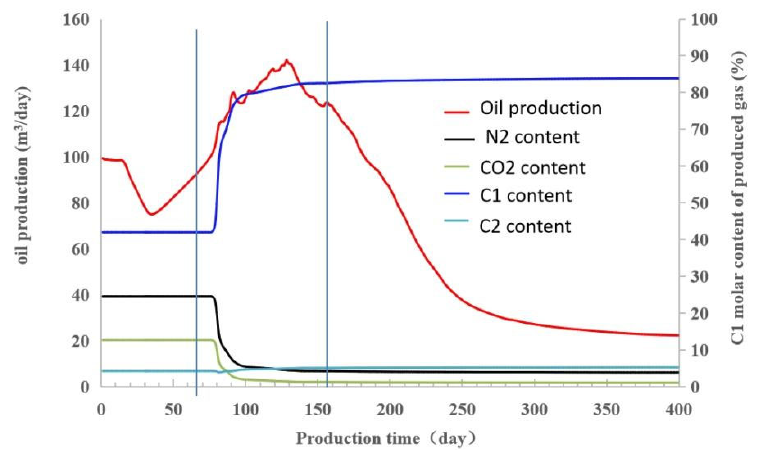
Figure 3. Analysis of gas channeling parameter selection.